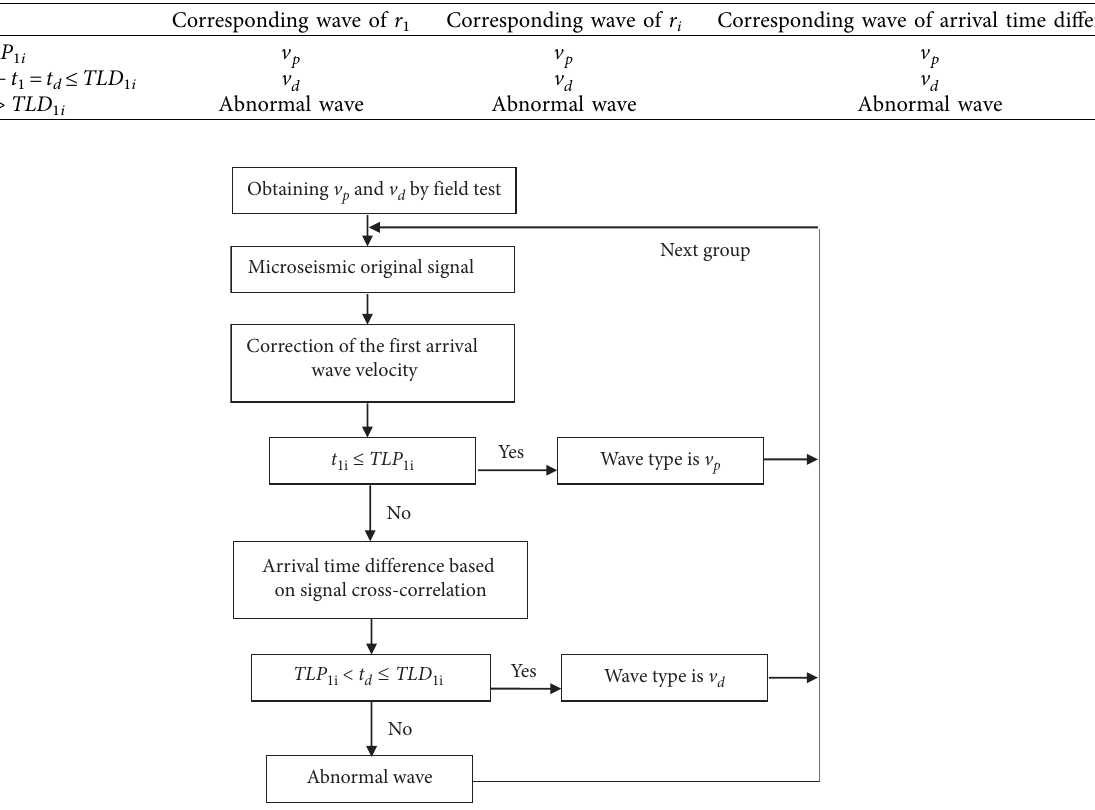
Figure 9: The procedure of velocity correction of the first arrival wave.